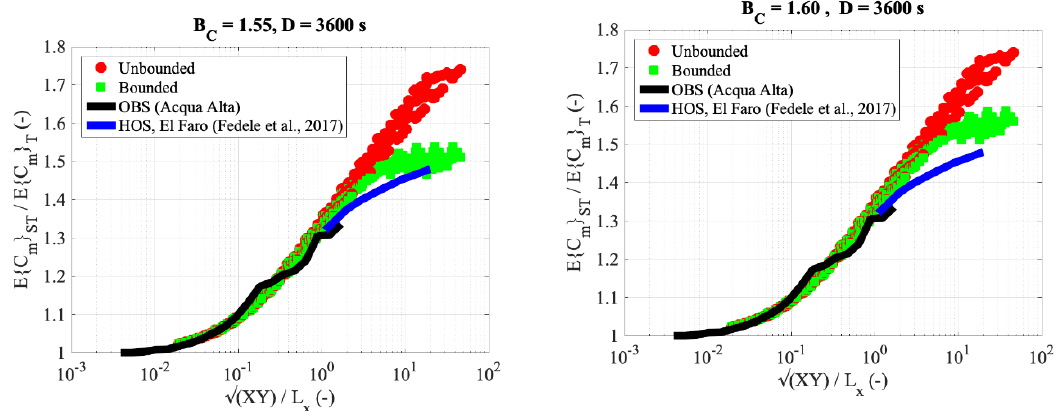
Figure 3. Assessment of the space-time extreme bounded distribution of C m . Theoretical ratio between space-time (ST) and time (T) extreme expectations as a function of the normalized sea surface area width ( XY ) 1 / 2 / L X ( L X is the spectral mean wavelength) for the unbounded (red markers) and the bounded distribution (green markers). The time-interval duration is D = 3600 s, as in Fedele et al. [6]. OBS: stereo observations from the Acqua Alta oceanographic platform (Adriatic Sea, Italy, [62]); HOS: Higher-Order pseudo-Spectral numerical simulations (adapted from [6]). ( left ) Upper bound B C = 1.55, and ( right ) upper bound B C = 1.60.